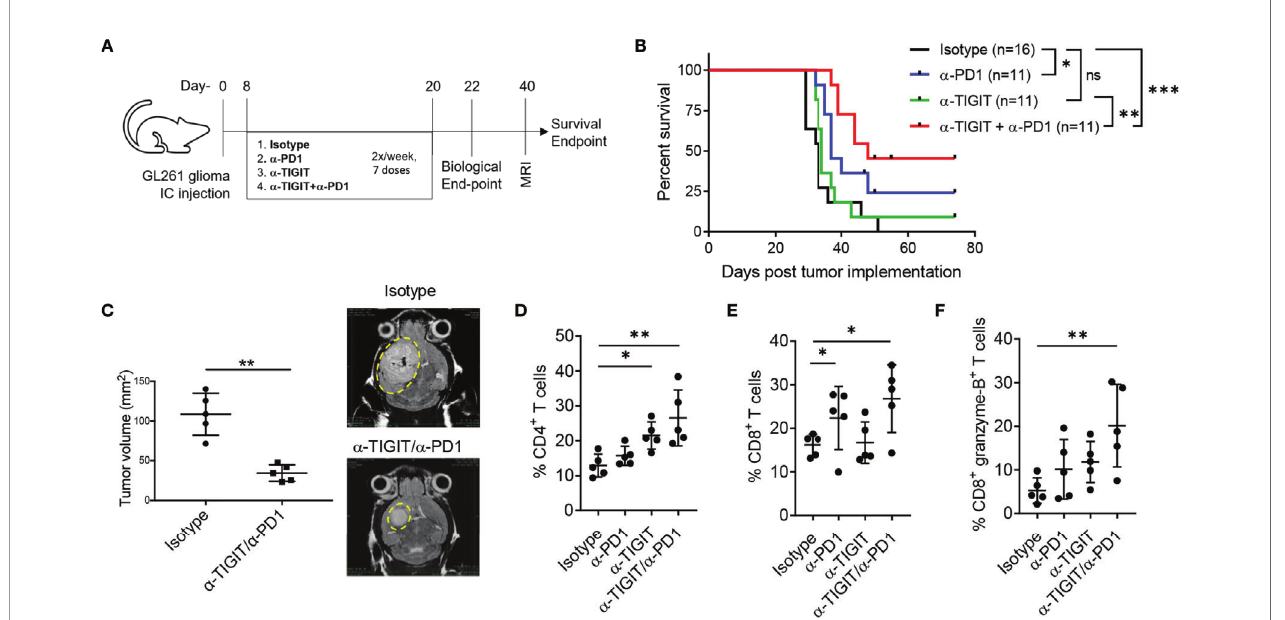
FIGURE 4 | Anti-TIGIT and anti-PD1 combination improves survival of GL261 glioma bearing mice. GL261 glioma cells were injected stereotactically in the caudate putamen of C56BL/6J mice followed by immunotherapy treatment starting on day 8 post tumor injection. Mice were evaluated for T cell responses on day 22 (biological endpoint) and for tumor size by day MRI on day 40. (A) Schematic showing induction of GL261 glioma in mice following treatment regimen using anti-PD1 and anti-TIGIT immunotherapies. (B) Survival curves with Log-rank (Mantel-Cox) curve comparison test. Pooled data from 3 independent experiments. (C) Pooled data and representative MRI images of tumor growth in murine GL261 glioma model in anti-PD1/anti-TIGIT treated group and isotype (control) treated animals. Unpaired t test with Welch ’ s correction. n=5 per group. (D – F) Percentages (%) of CD45 + glioma-in fi ltrating CD4 + T cells (D) , CD8 + T cells (E) , and CD8 + granzyme B + T cells (F) , on day 22 following anti-TIGIT/anti-PD1 immunotherapy. Representative data of 3 experiments. n=5 per group. One-way ANOVA with multiple comparisons test corrected for false discovery rate (FDR) using Benjamini-Hochberg test. P values are as followed: * ≤ 0.05, ** ≤ 0.01, *** ≤ 0.001. NS, not signi fi